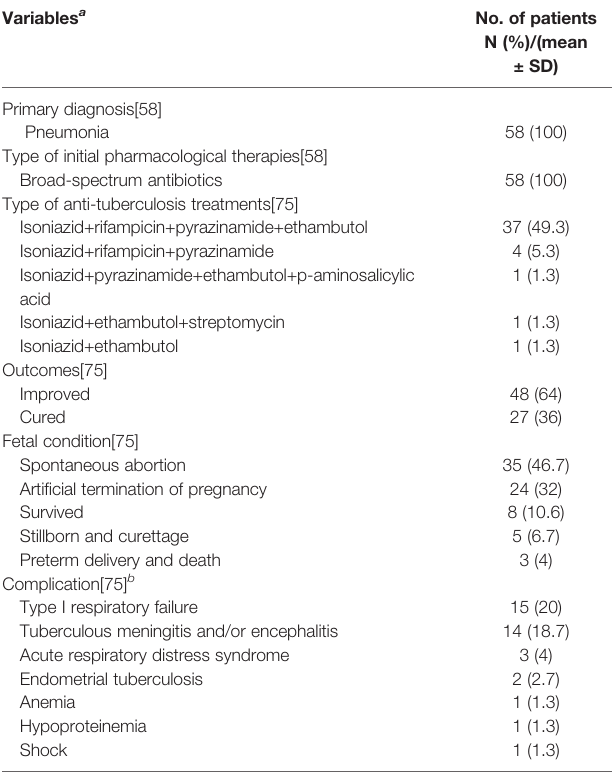
TABLE 5 | Treatment, outcomes, and complications. Variables